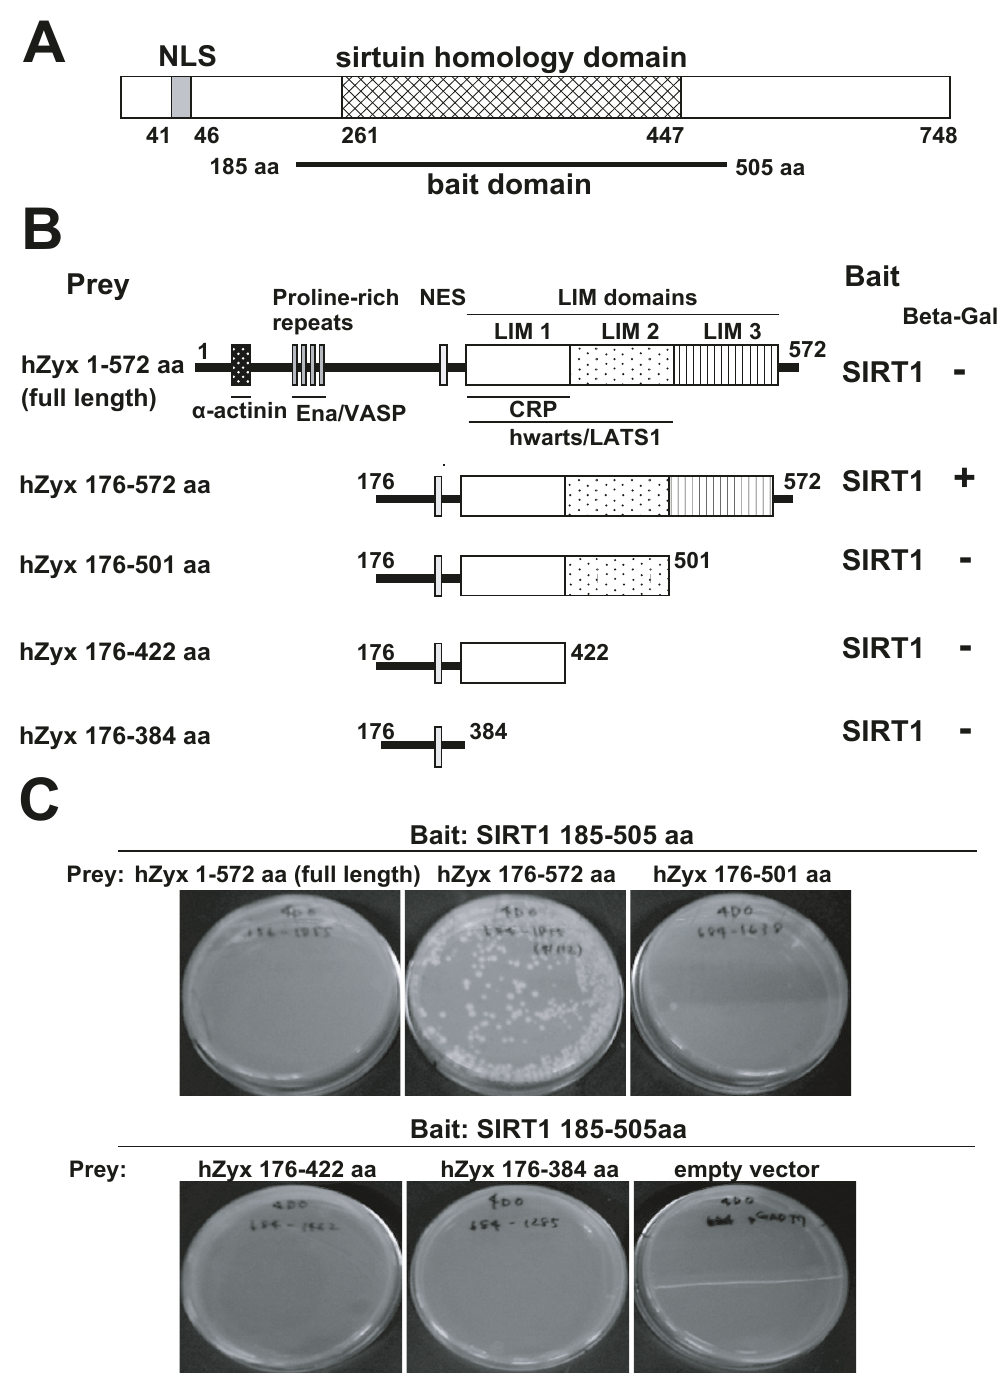
Figure 1 Interaction between SIRT1 and zyxin in yeast . (A) Schematic representations of SIRT1 are shown with the sirtuin homology domain. The bar below the SIRT1 structure shows the region used as the bait domain in the yeast two-hybrid sys- tem. (B) Schematic diagram of zyxin and its deletion mutants are shown with their domain structures and representative bind- ing partners. (C) In the yeast two-hybrid binding assay, the yeast reporter line (AH109) was co-transformed with plasmids encoding the SIRT1 catalytic domain and various zyxin deletion mutants on a 4-DO (drop out) medium. The line was photo- graphed after 14 days of